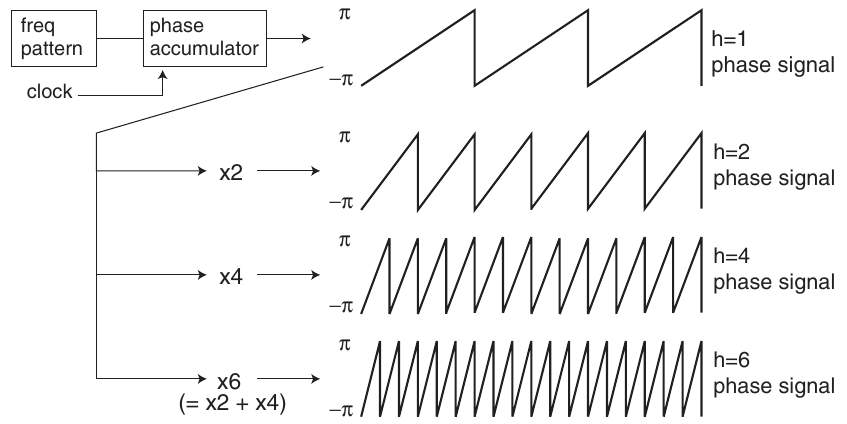
FIG. 5. Direct digital synthesis (DDS).